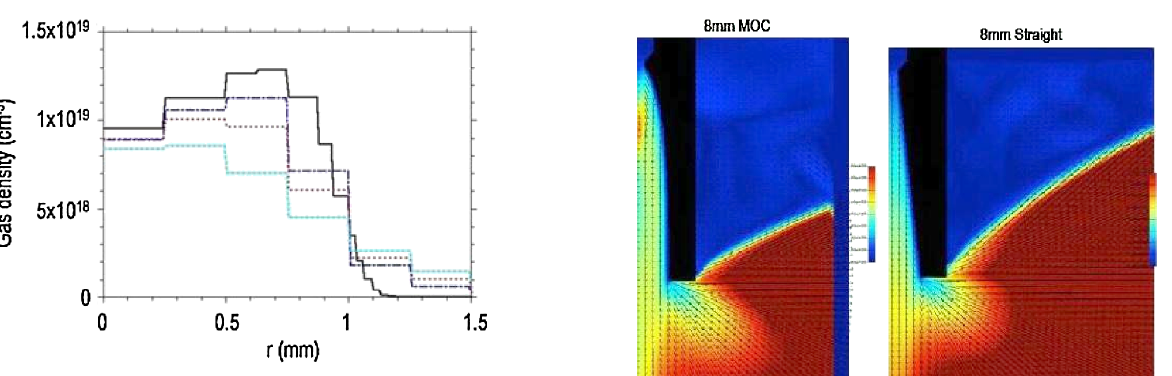
FIG. 10. Mach number contours for the 8 mm MOC and 8 mm straight nozzles with velocity vectors superimposed on the flow